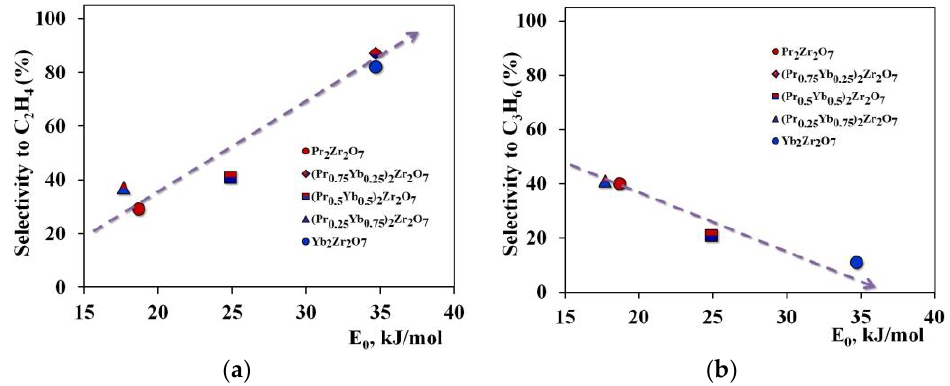
Figure 10. Dependence of selectivity for target products on the strength of the interaction of the reactant with the catalytic center ( a ) — for ethylene, ( b ) — for propylene. The decrease in selectivity for ethylene and the increase in the amount of propy- lene in the reaction products observed in the series of propane cracking Pr 2 Zr 2 O 7 (cid:57)(cid:57)(cid:75) (Pr 0.75 Yb 0.25 ) 2 Zr 2 O 7 (cid:57)(cid:57)(cid:75) (Pr 0.5 Yb 0.5 ) 2 Zr 2 O 7 (cid:57)(cid:57)(cid:75) (Pr 0.25 Yb 0.75 ) 2 Zr 2 O 7 (cid:57)(cid:57)(cid:75) Yb 2 Zr 2 O 7